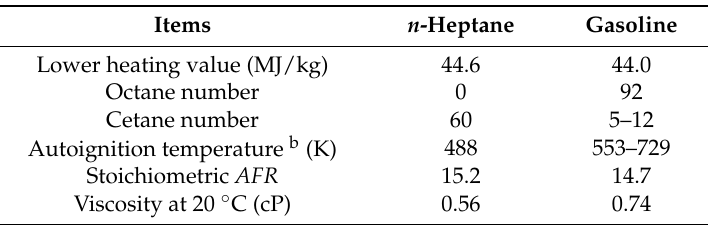
Table 2. Fuel Properties. AFR : air–fuel